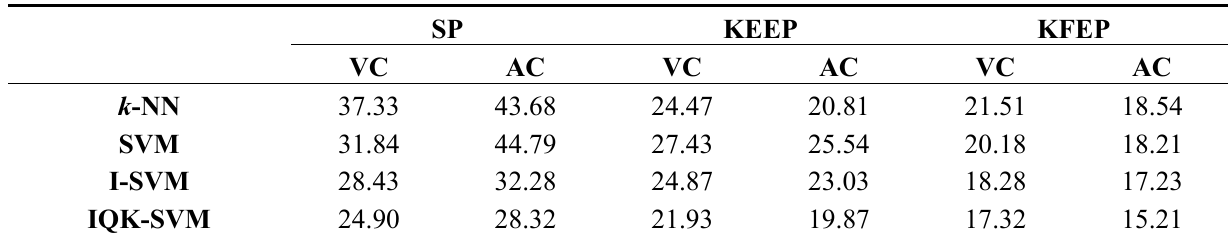
Table 3. Average error rates of 10 participants for different combinations of feature and classifier (%).